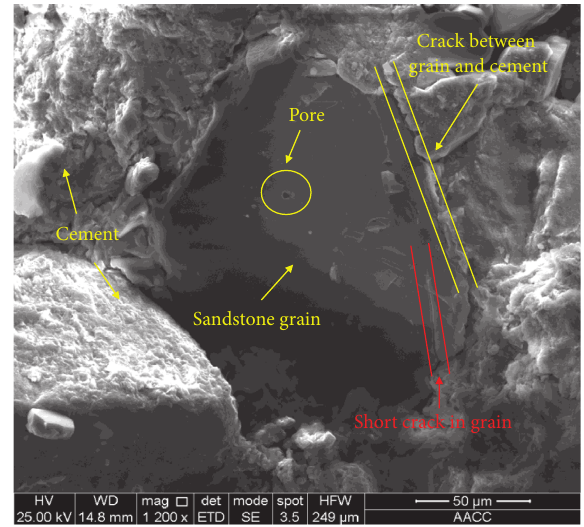
Figure 18: Electrical microscopy scan before the test.